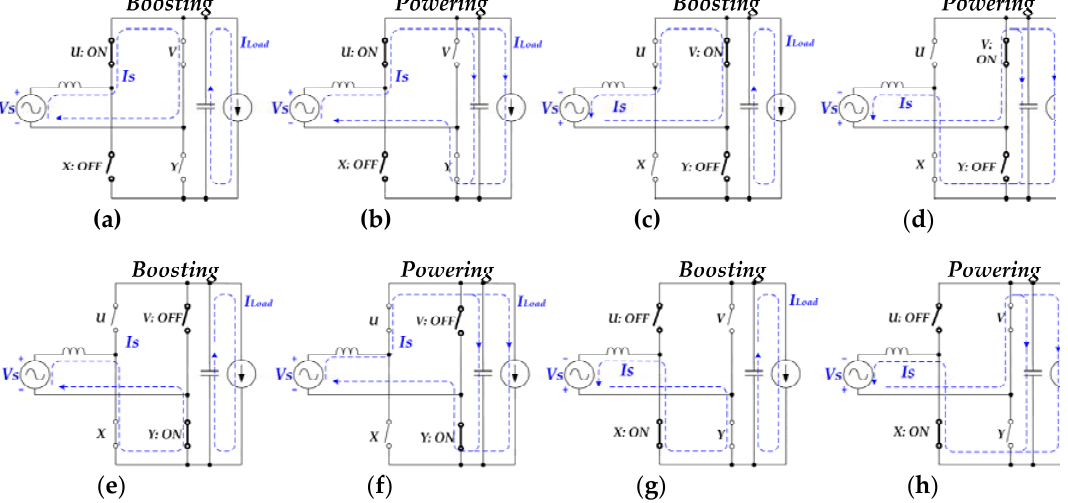
Figure 7. Equivalent circuits for DPWM based single ‐ phase PWM converter during one power cycle when adopting UCM ( a – d ), and LCM ( e – h ). when adopting UCM ( a – d ), and LCM ( e – h